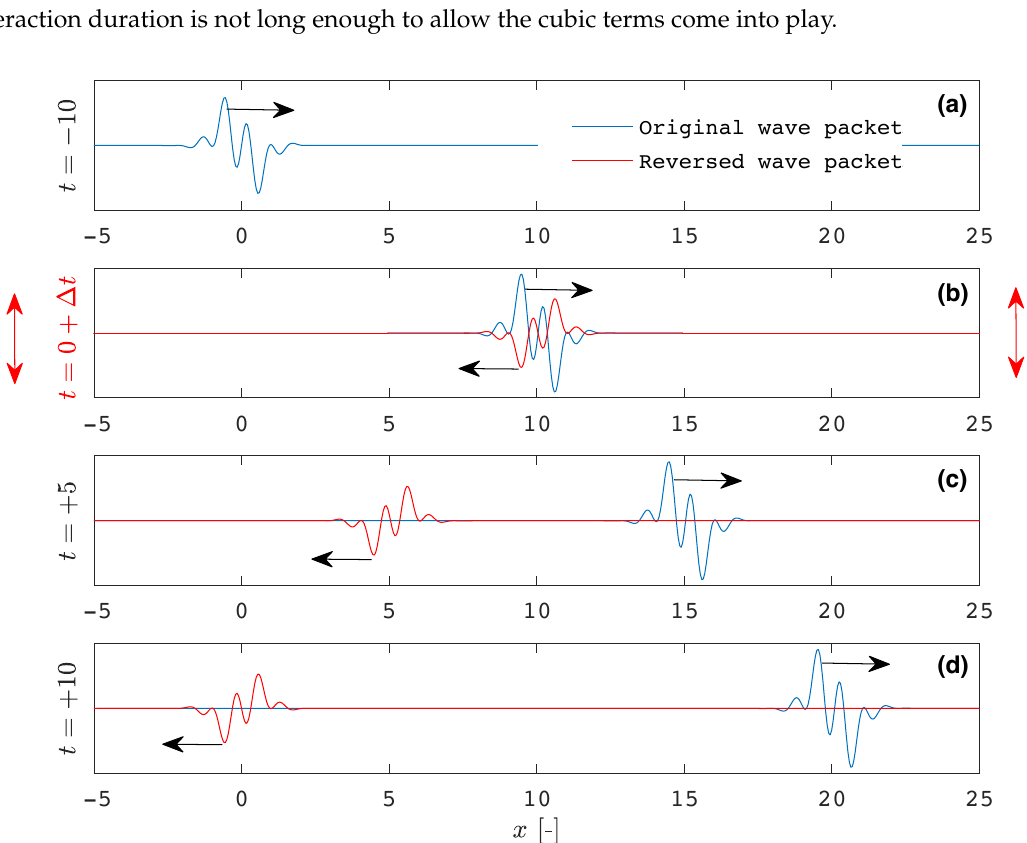
Figure 1. Time reversal of a gravity wave packet (blue) interacting with sudden vertical oscillation by an acoustic mode, n = 0. Each subplot represents a different time snapshot. The original wave packet amplitude S + = e − X 2 sin3 X cos5 X travels solely in ( a ); the triad interaction starts at time T = 0 for a duration of ∆ T , which generates a gravity wave (red) with a similar wave packet ( b ) that travels in an opposite direction as illustrated in ( c , d